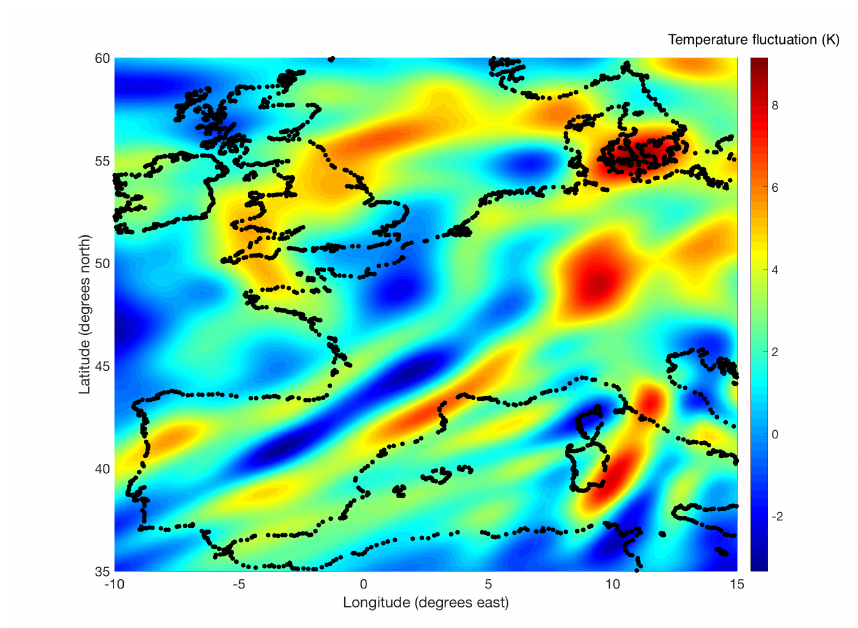
Figure 3. Horizontal field of anomaly temperature extracted from ERA5 re-analysis during the night of 12–13 December 2017 at 18 h UT over Western Europe around 49 km